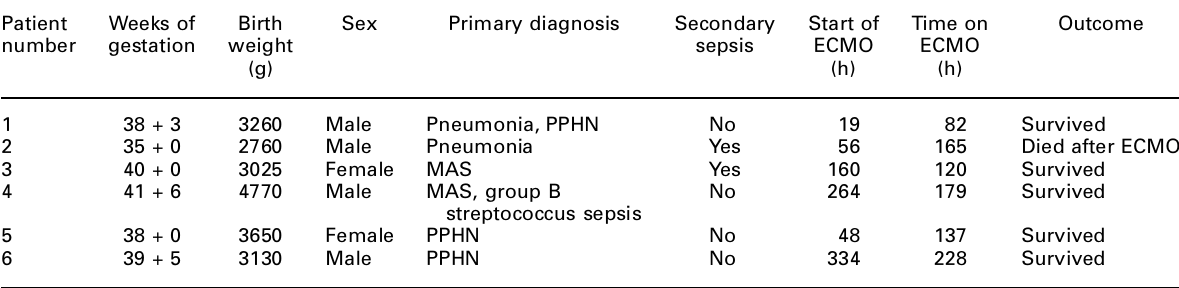
Table 1. Clinical data of six newborns undergoing ECMO treatment for severe respiratory failure Patient